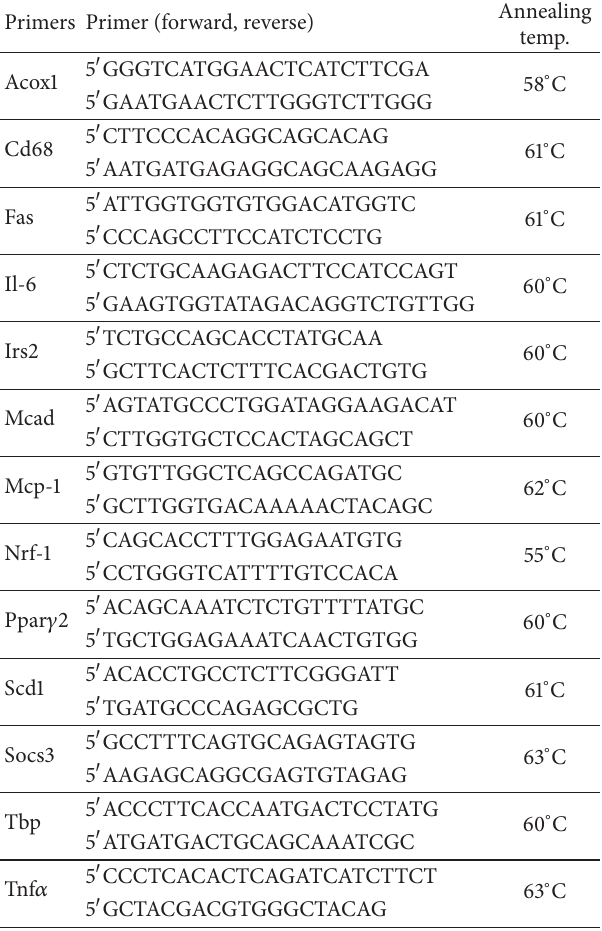
Table 2: Primer sequences and annealing temperatures. Primer sequences and annealing temperature are depicted for relevant primer pairs. Primers Primer (forward, reverse)